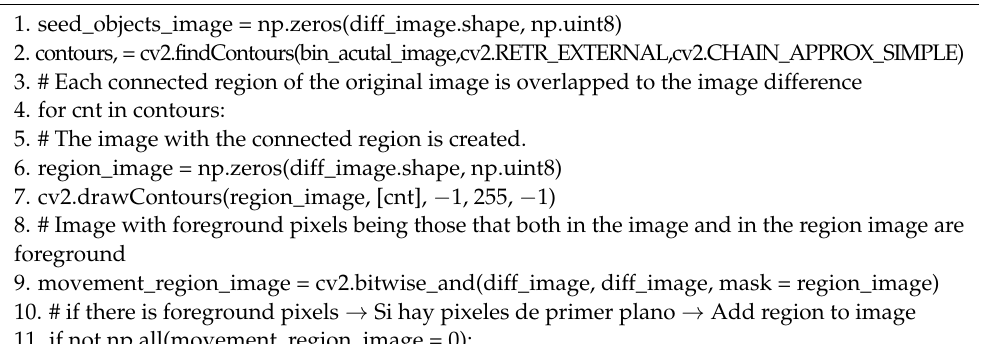
Algorithm 1. Pseudocode for for checking the regions of the current image to which moving pixels belong.